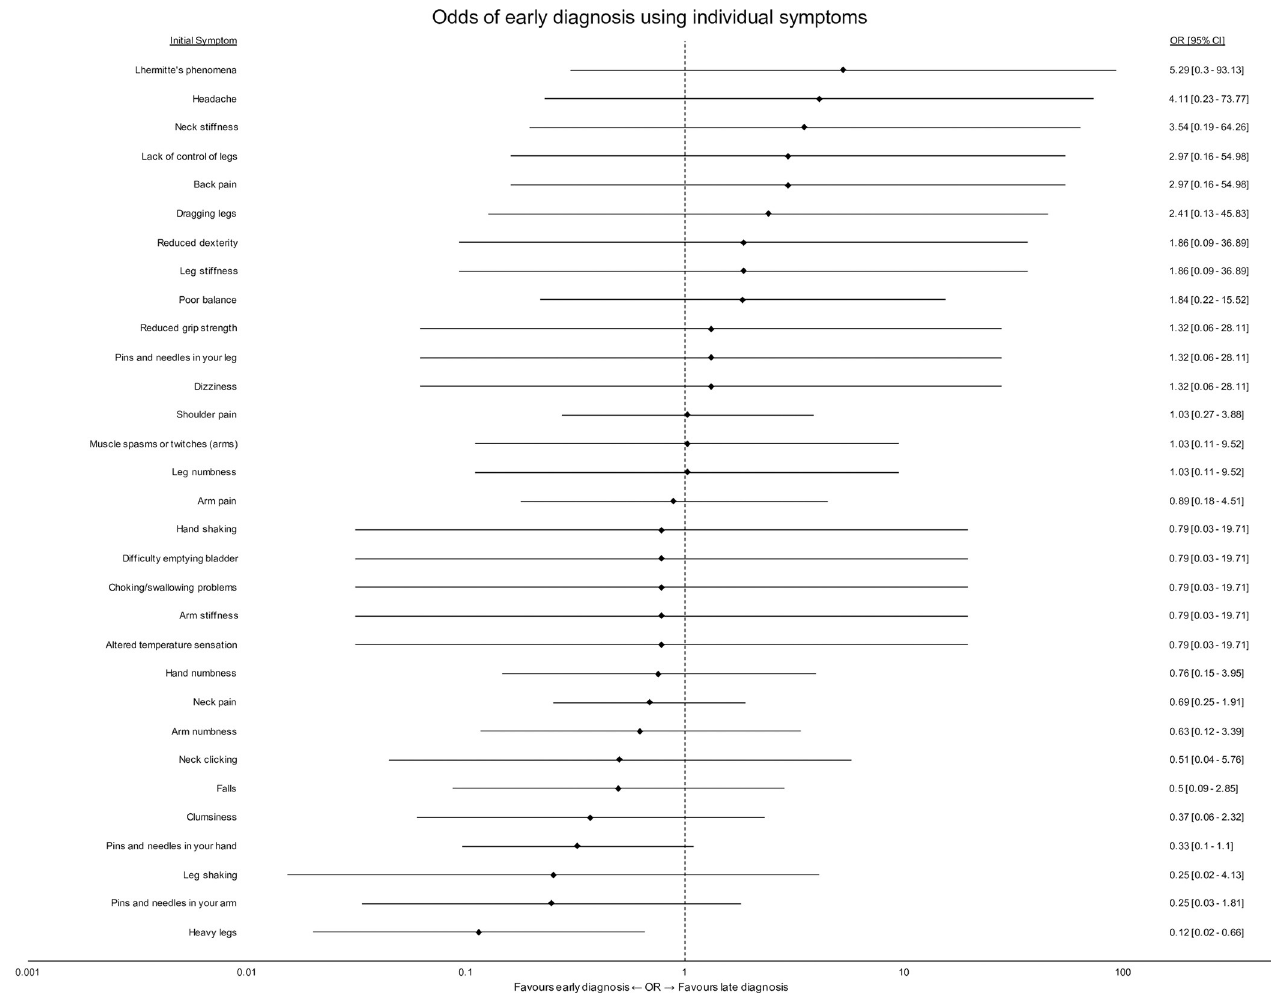
Fig 6. Odds of early diagnosis using individual symptoms. A forest plot of individual odds ratios for each initial symptom. Error bars represent 95% confidence intervals of the odds ratio.